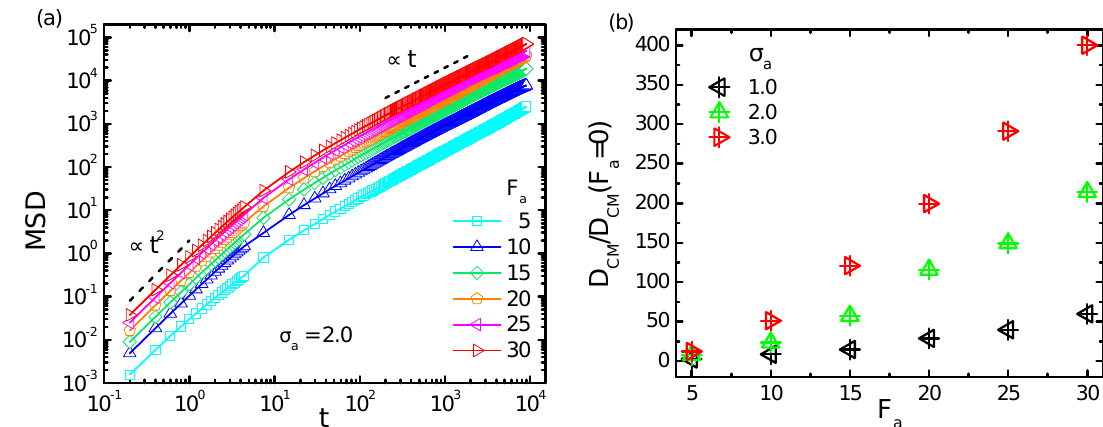
Figure 7. ( a ) Mean squared displacement (MSD) of the center of mass (CM) for the semiflexible chain with κ = 1.0, in an active bath with σ a = 2.0 at φ = 1.0. ( b ) The scaled diffusion coefficient D CM / D CM ( F a = 0 ) as a function of active force F a , for σ a = 1.0, 2.0, and